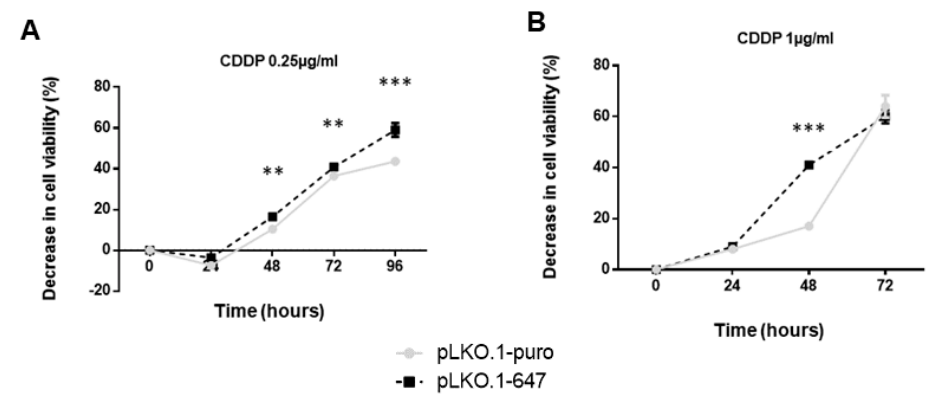
Figure 4. Impact of chemotherapeutic drugs on cell viability of OSCC cells. MTT assay was used to evaluate the effect of CCDP treatment on cell viability of PON2 downregulating cells (pLKO.1-647) and controls (pLKO.1-puro), related with HSC-3 ( A ) and HOC621 ( B ) cell lines. Measurements were performed at 0, 24, 48, 72 and 96 h for HSC-3 and at 0, 24, 48 and 72 h for HOC621. All values are expressed as mean ± standard deviation (** p < 0.01; *** p < 0.005). For both cell lines, at all tested timepoints, 5-FU alone or combined with CDDP did